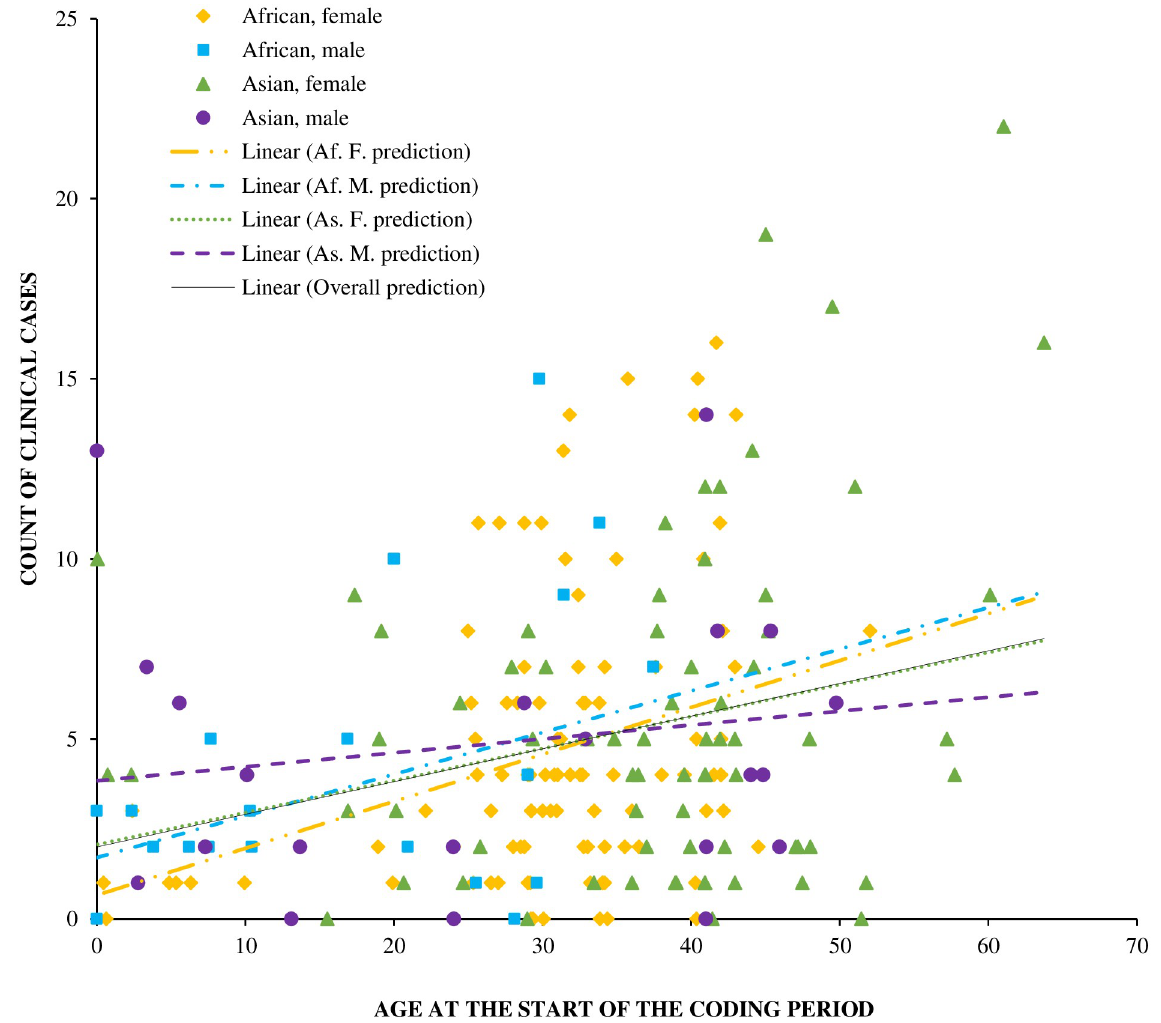
Fig 2. Clinical events by age. The number of clinical events recorded for each individual elephant, plotted according to their age at the start of the recording period. Markers denote individual elephants by species and sex; fit lines represent the GLMM predicted number of clinical events by age according to species, sex and